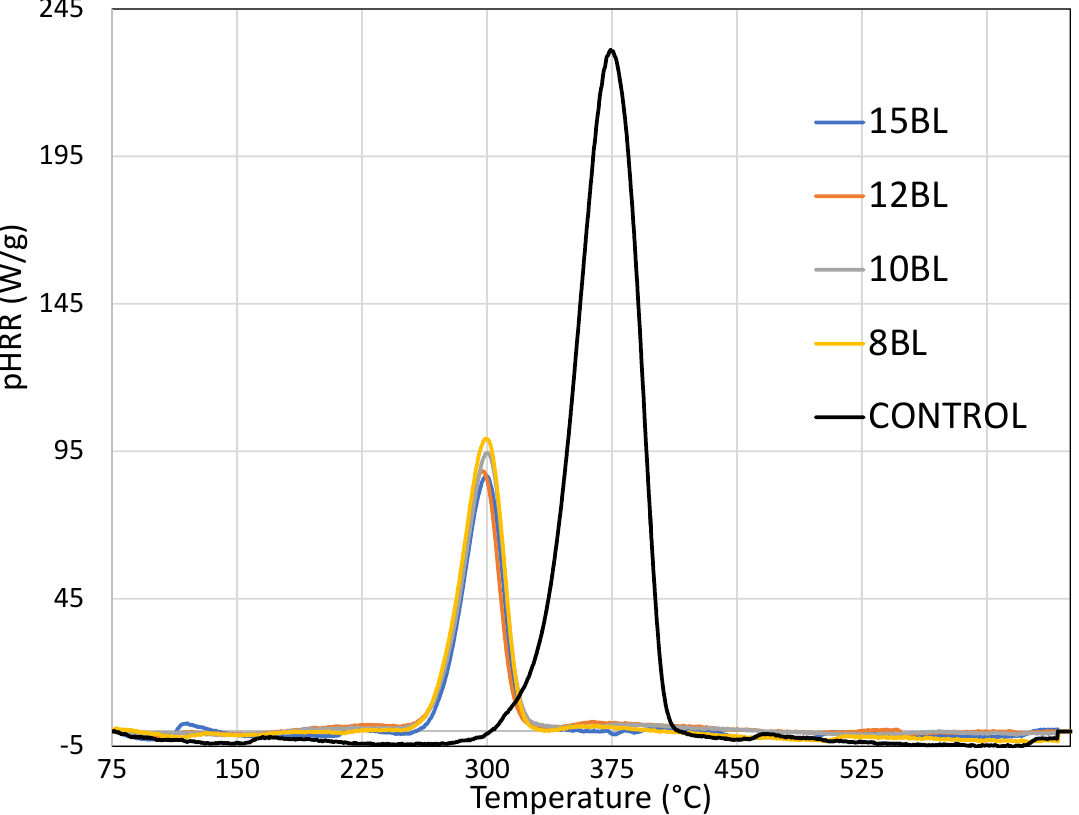
Figure 2. Heat release rates as a function of temperature for cotton treated with varying bilayers (8 BL-15 BL) of PA/CH-urea.